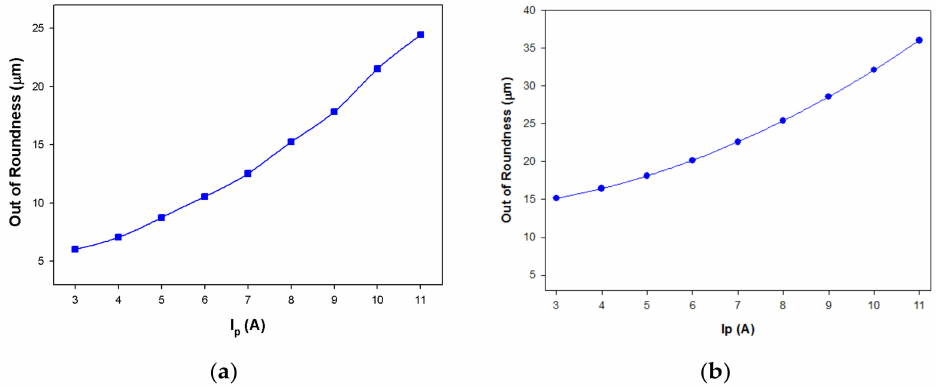
Figure 18. Main effect plots for change in OOR with I p using ( a ) DOE model; ( b ) machine learn- ing